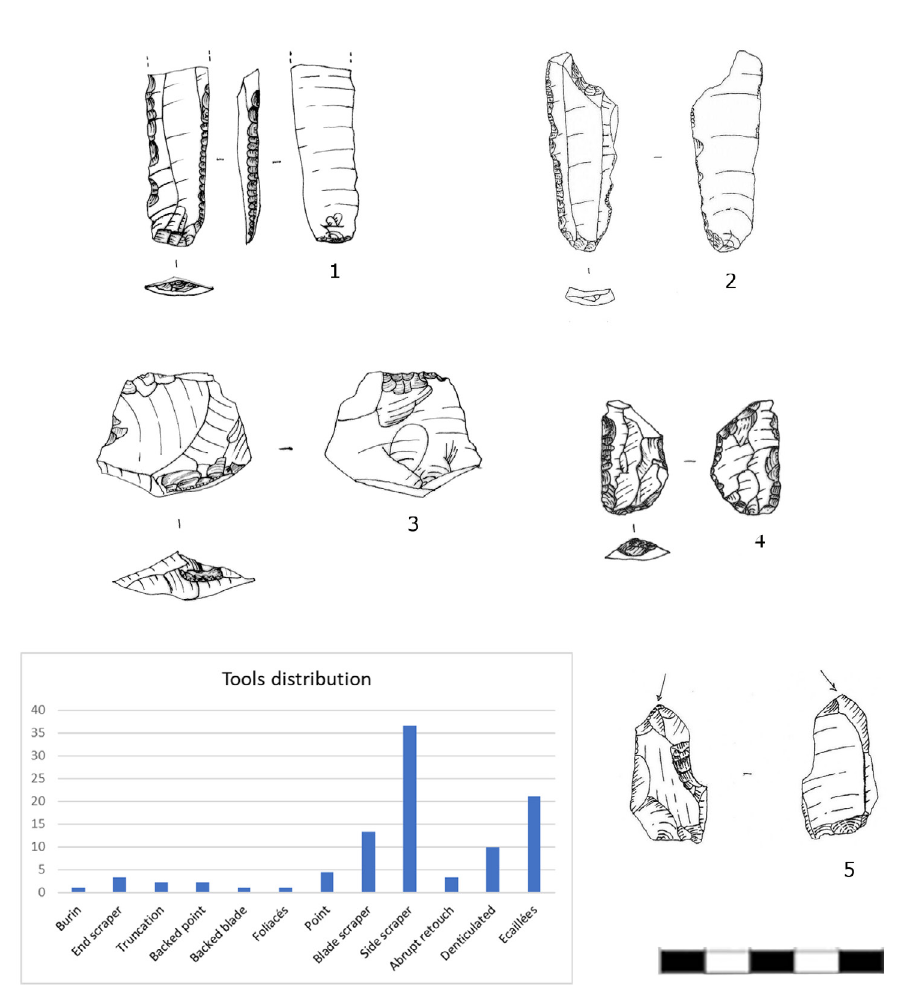
Figure 12. S. Martino. Tools from Stentinello occupation levels and